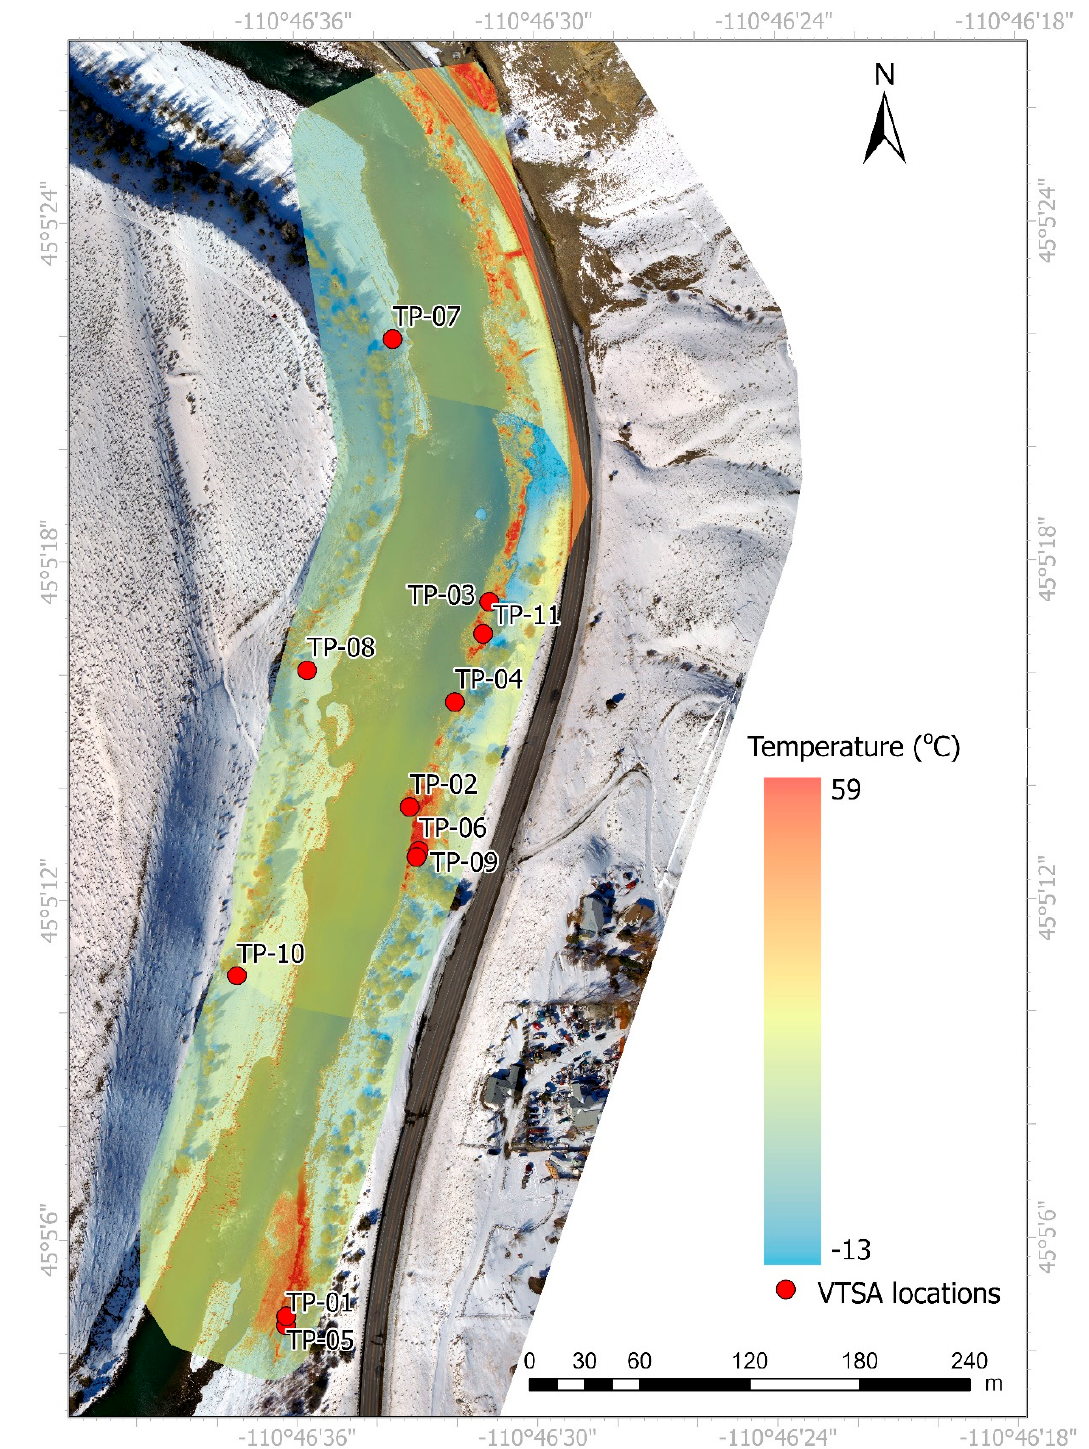
Figure 5. Map showing placement of Vertical Temperature Sensing Assemblies (VTSAs) in the study area. The RGB orthomosaic and TIR orthomosaic correspond to the flight data from March 2019. Table 1. Yellowstone River study area sediment properties.